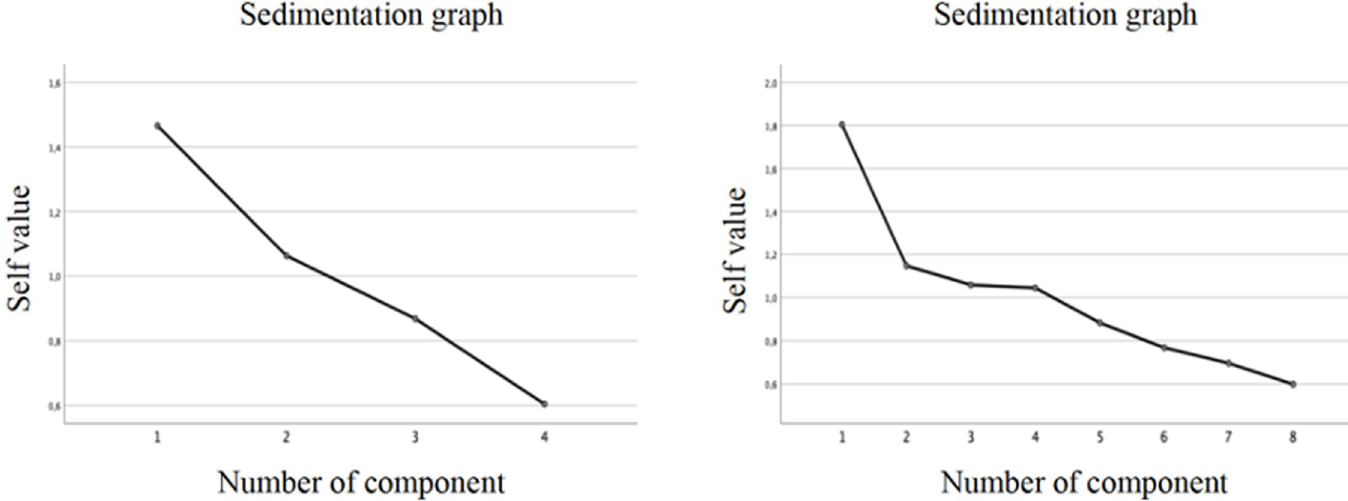
Fig 1. Comparison between the sedimentation graphs corresponding to the analysis of principal components for IGs (image on the left side) and for DLGs (image on the right side).